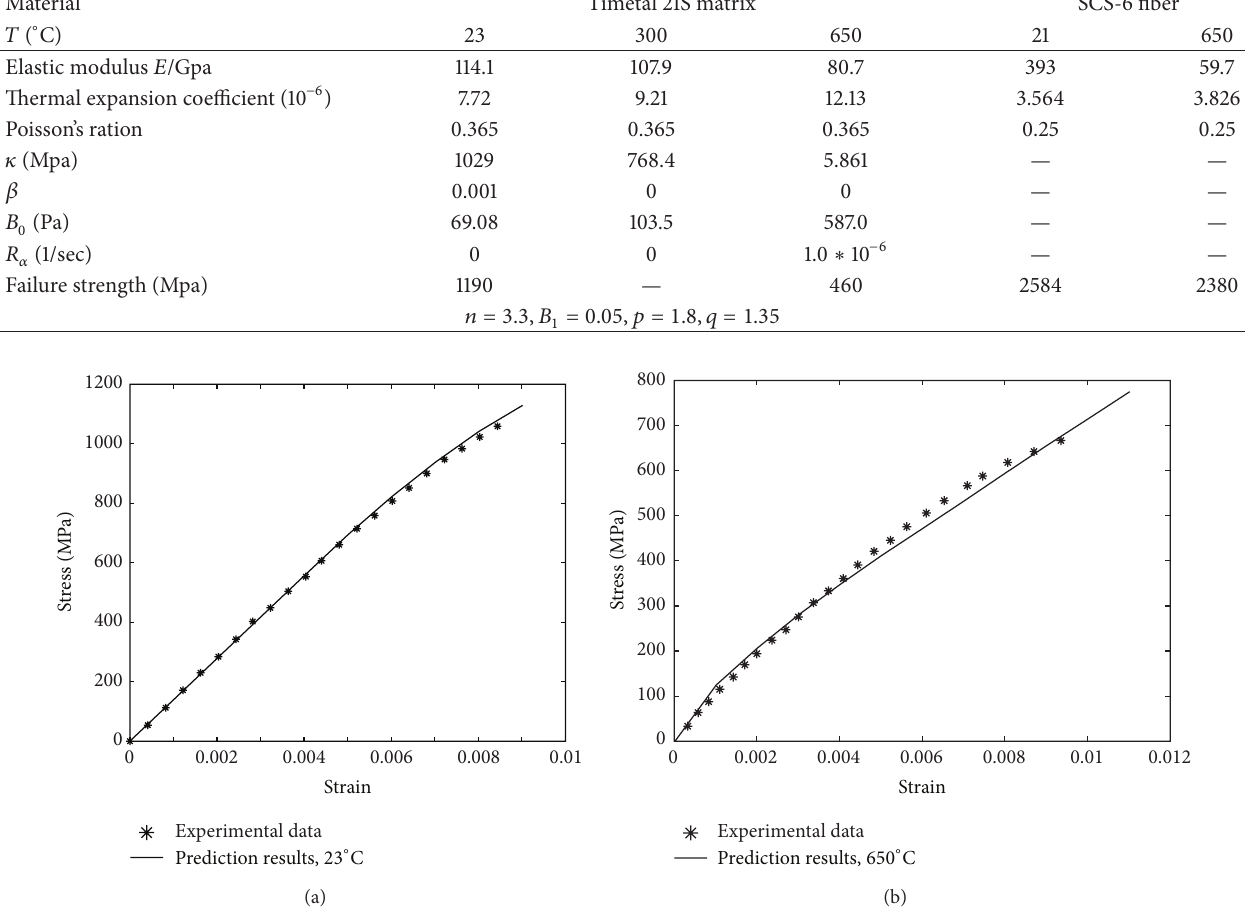
Figure 2: The predicted and experimental tensile stress-strain responses of [0/90]